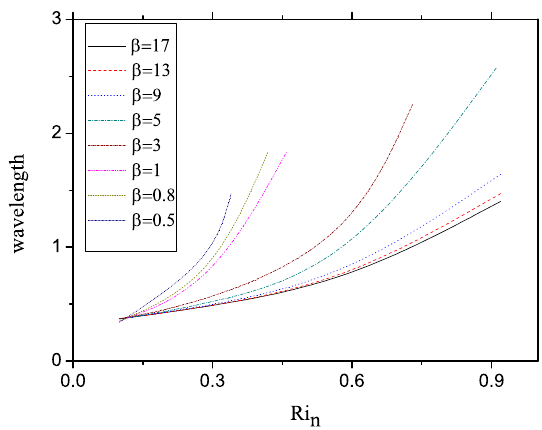
Figure 3. The relationships among typical